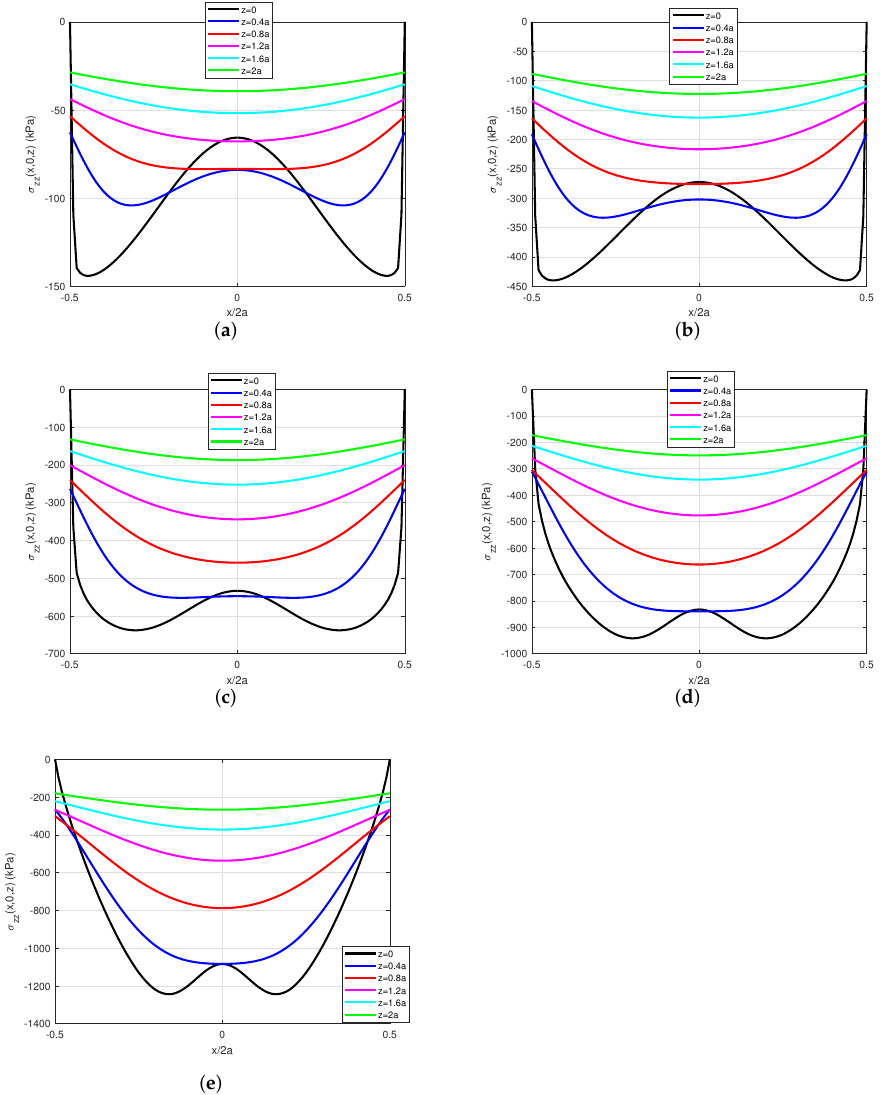
Figure 9. Vertical compressive stress σ zz in central cross sections with depth: ( a ) Case N1-T0; ( b ) Case N2-T0; ( c ) Case N3-T0; ( d ) Case N4-T0; ( e ) Case